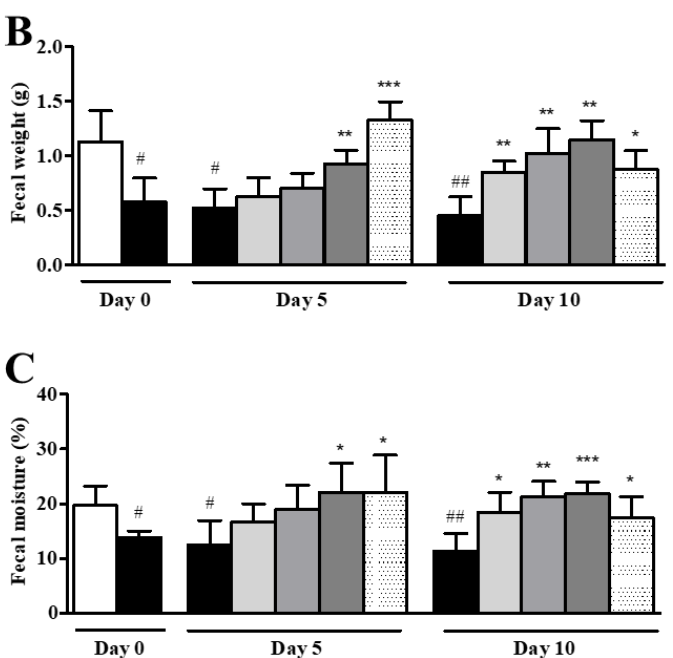
Figure 7. The laxative effects of D. morbiferus H. L é v. leaf extract (DPL) on loperamide-induced constipation. At 0, 5, and 10 days, the number ( A ), weight ( B ), and water content ( C ) of stools were measured. The fecal water content was calculated using the fresh and dry weights of stools. # Significant difference at p < 0.05, and ## at p < 0.01 compared with the control group (CTL). * Significant difference at p < 0.05, ** at p < 0.01 and *** at p < 0.001 compared with the loperamide-induced constipation group (negative control group; NCTL).